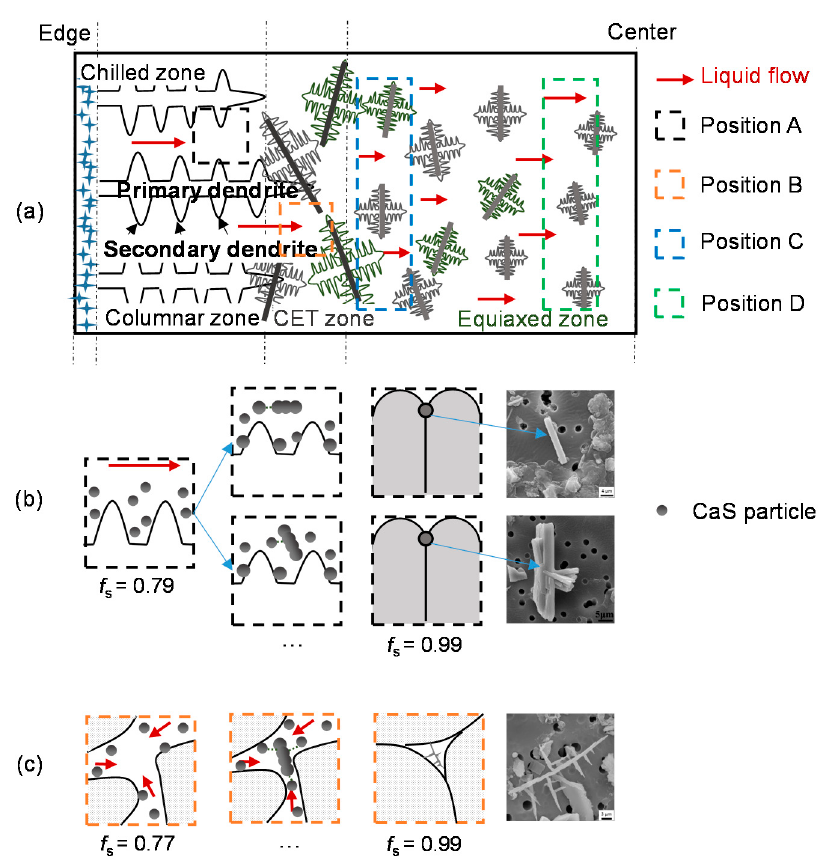
Figure 16. The growth of CaS inclusion in different macrostructure. ( a ) The view of macrostructure of slab; ( b ) the schematic diagram of CaS growth in columnar zone (position A); ( c ) the schematic diagram of CaS growth in CET zone (position B).